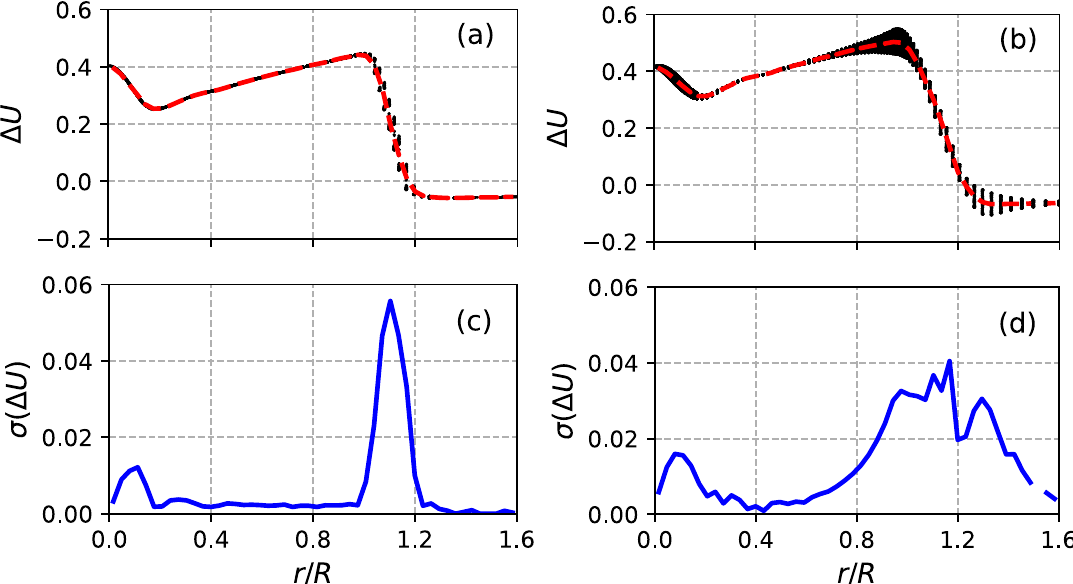
Figure 2. ( a , b ) Scatter data of the velocity deficit distribution along the blade radius and variable azimuthal angle, at 1D downstream of the rotor plane. The red curve is the average value. ( c , d ) The standard deviation of the mean axial velocity deficit. The left panels are associated with a balanced case, while the right panels are associated with the unbalanced case with a pitch imbalance of 5 ◦